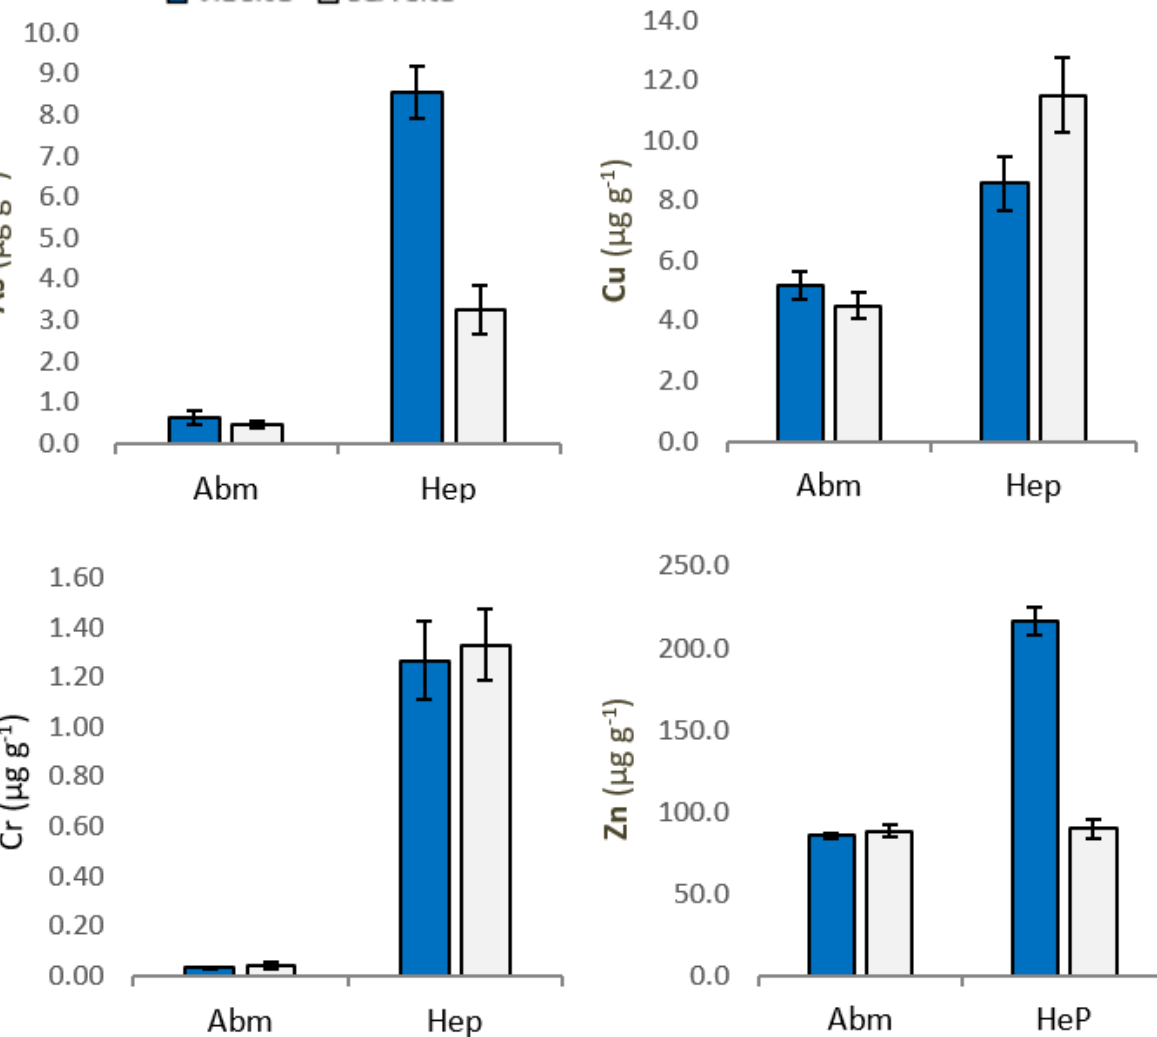
Figure 2. Concentrations of As, Cu, Zn and Cr in Procambarus clarkii abdominal muscle (AbM) and hepatopancreas (Hep) from Villa Literno (ViL) and Sessa Aurunca (SeA). Vertical bars represent average concentration (µg g − 1 wet weigth) ± SEM.